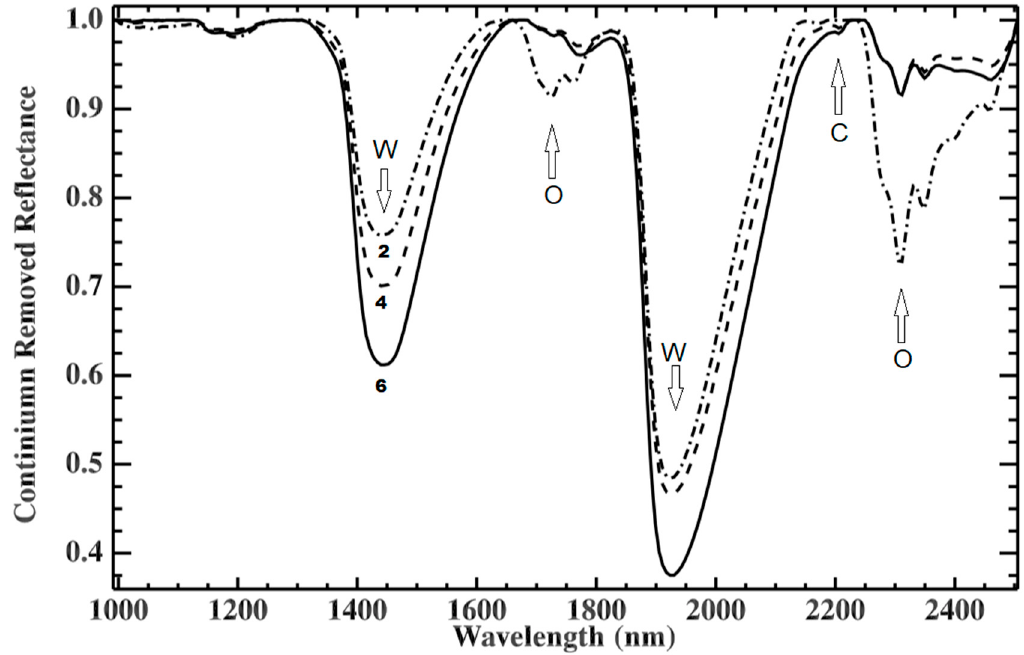
Figure 4. Average point spectra for samples Sp#2, 4, and 6. The spectra are shown with the continuum remove to facilitate the identification of prominent absorption features due to water (W), oil (O), and clay minerals (C). Line patterns: Sp#2 dot-dashed, Sp#4 dashed, Sp#6 solid. Numbers 2, 4 and 6 in the figure are for Sp#2, 4, and 6